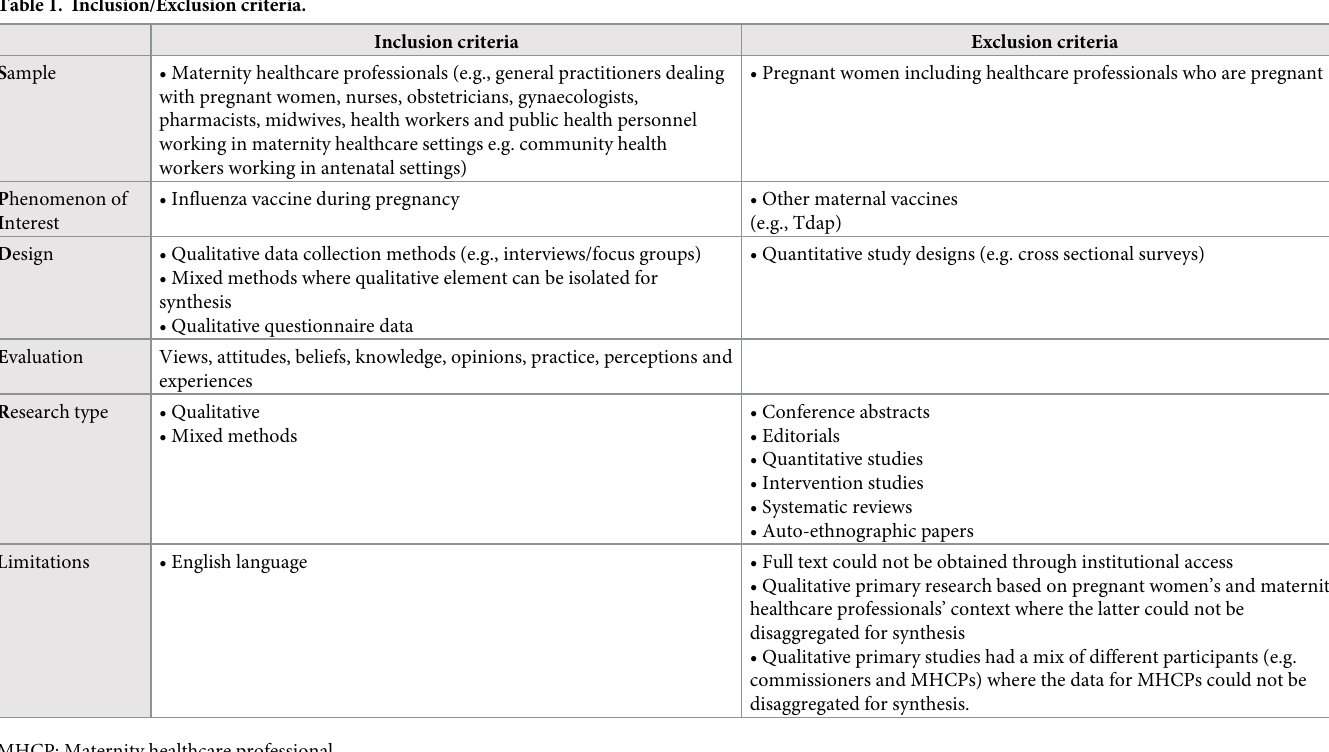
Table 1. Inclusion/Exclusion